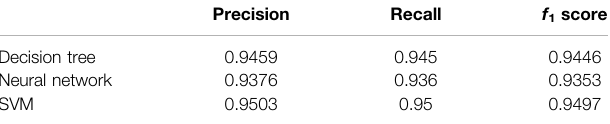
TABLE 2 | Detection of raw data.